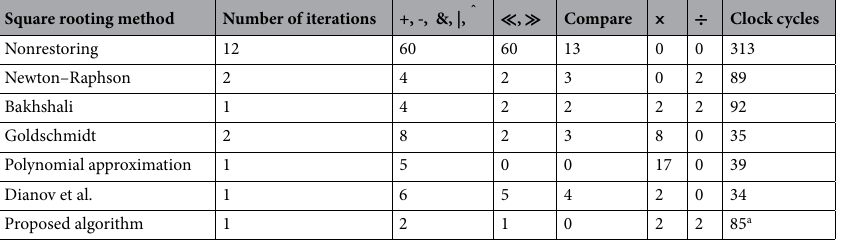
Square rooting method